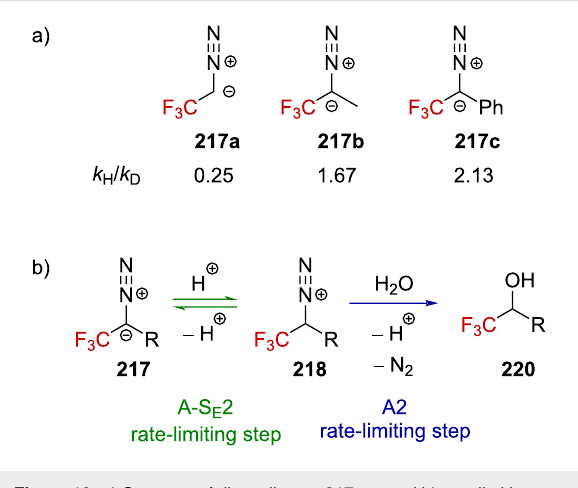
Figure 10: a) Structure of diazoalkanes 217a – c and b) rate-limiting steps of their